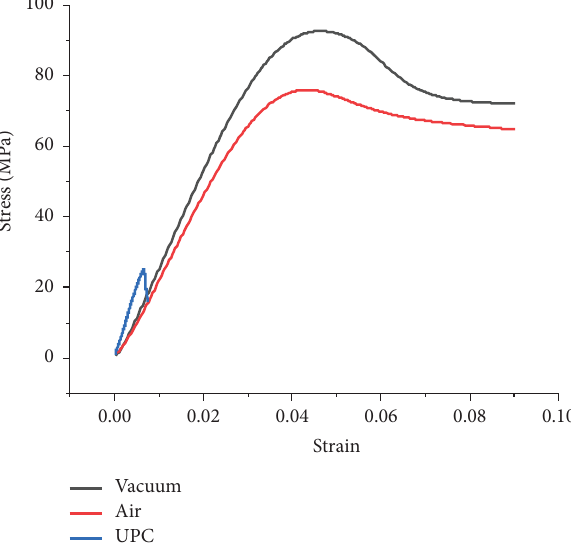
Figure 14: Uniaxial stress-strain curves for diferent k